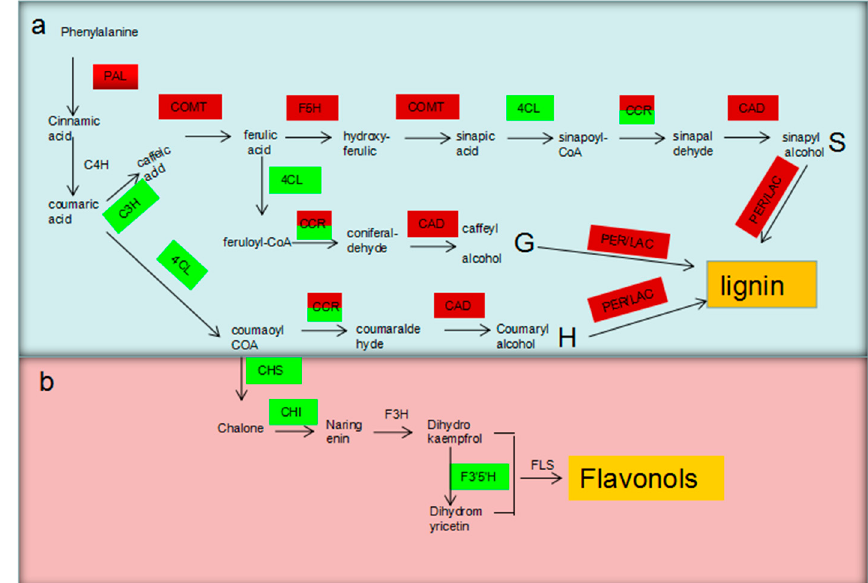
Figure 4. Simplified biosynthetic pathway of lignin and flavonols. ( a ) The lignin biosynthetic pathway; ( b ) the biosynthetic pathway of flavonols; upregulated and downregulated genes are denoted with red and green backgrounds, respectively, while nondifferentially expressed genes are denoted with no background. Table 2. Selected significantly differentially expressed genes related to phenylpropanoid biosynthesis and cellulose biosynthesis in roots of “Nanlin895” exposed to boron deficiency.